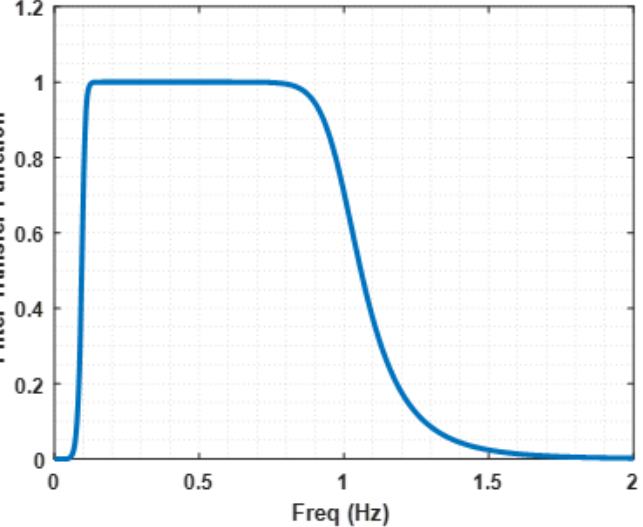
Figure 4. Filter transfer function, F . This filter represents the one used in the automatically detected contractions processing [48].